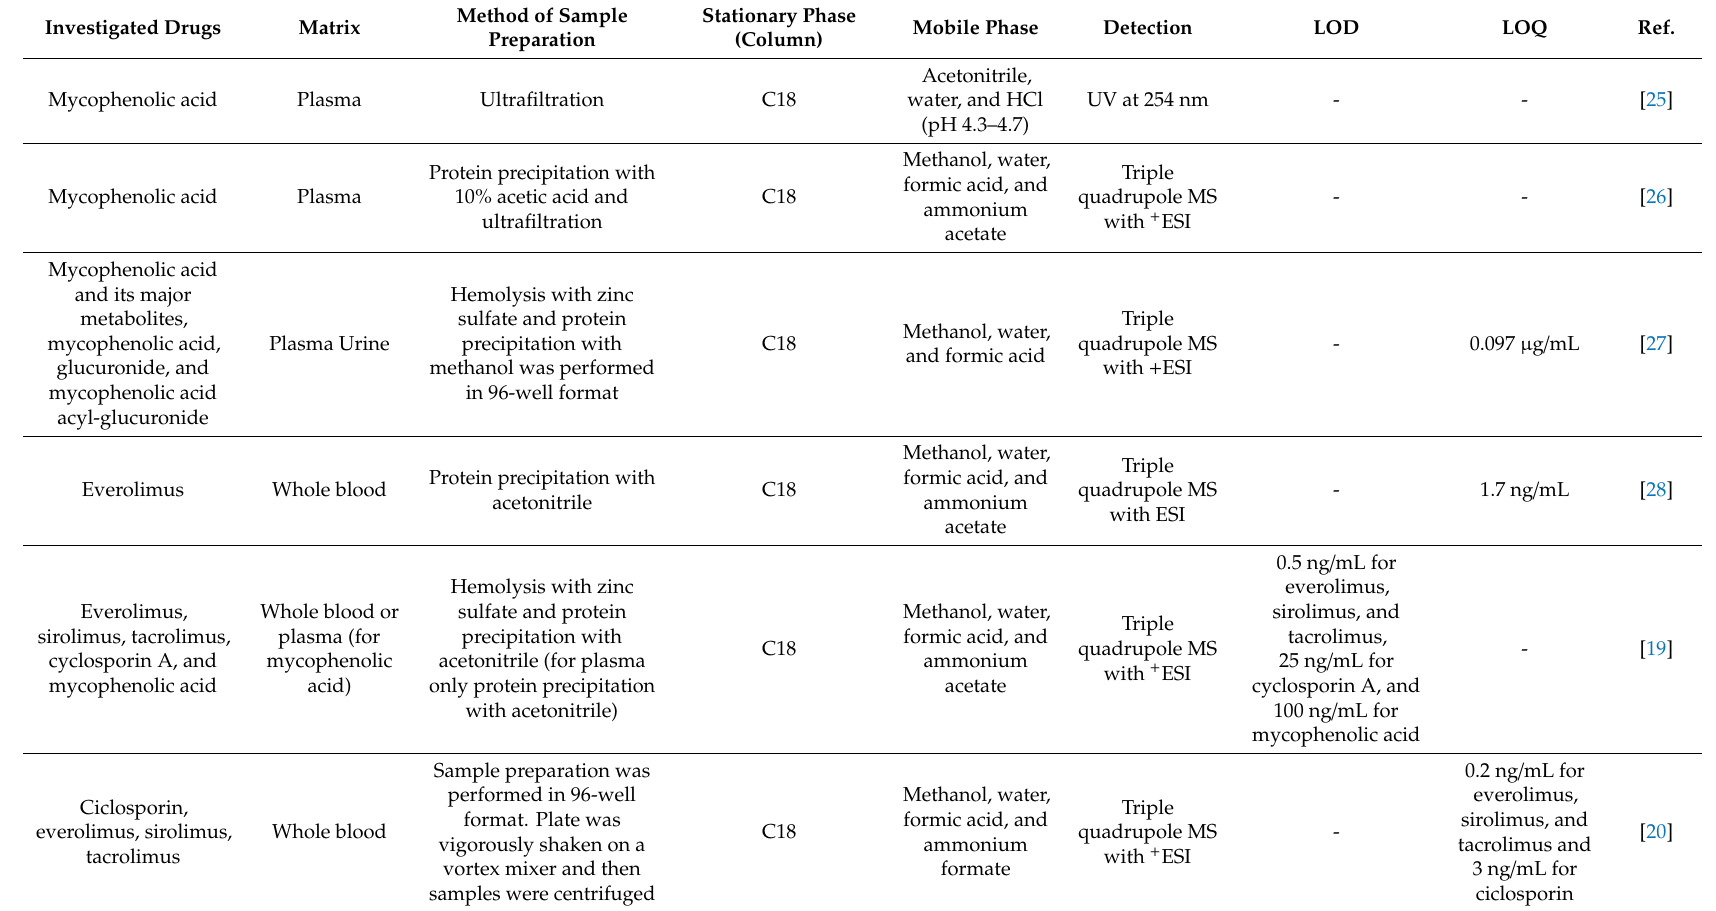
Table 1. Immunosuppressive drugs. ESI: electrospray ionization, LOD: limit of detection, LOQ: limit of